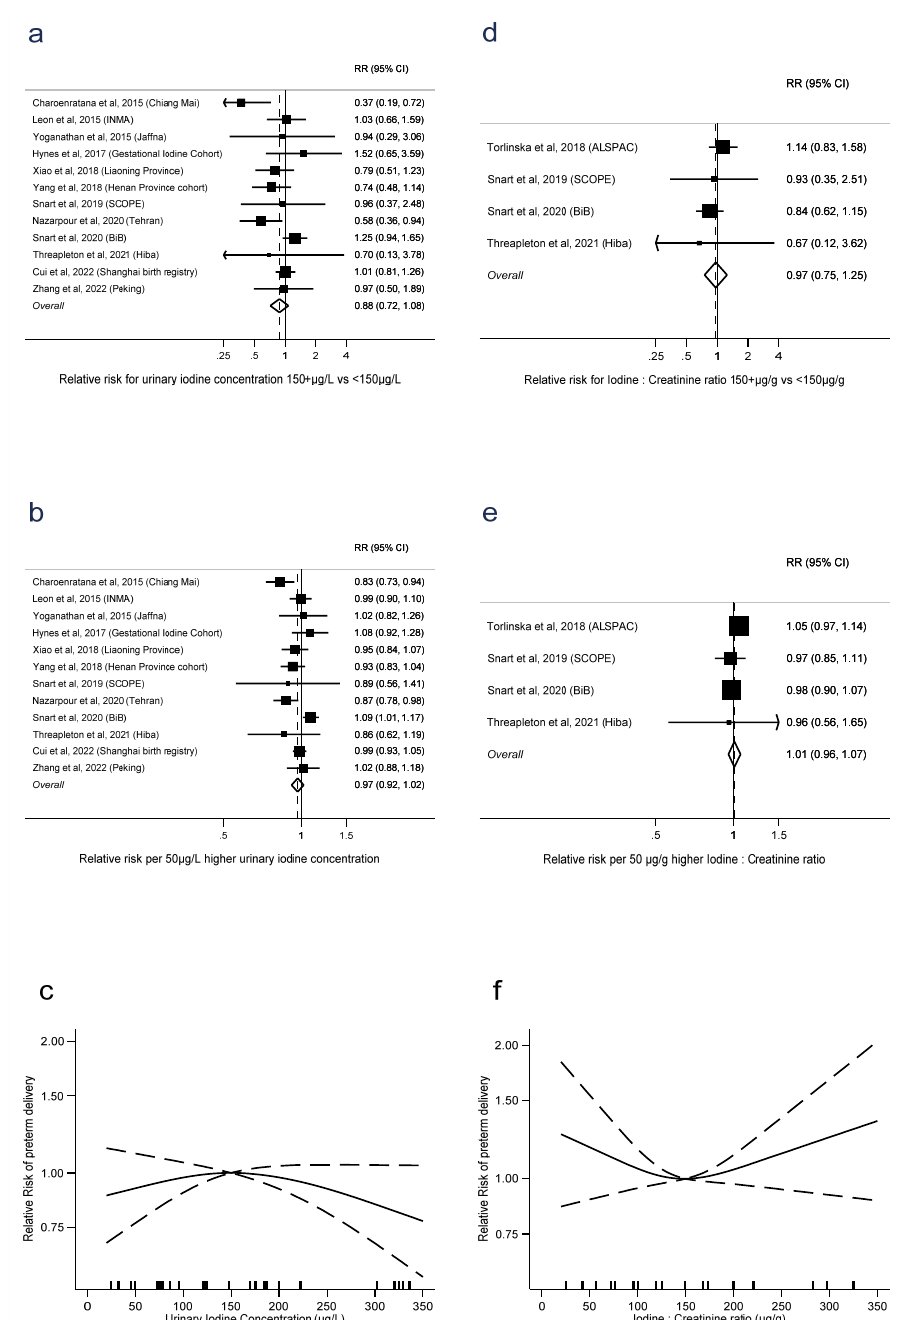
Figure 5. Urinary iodine concentration ( a – c ), iodine to creatinine ratio ( d – f ) and preterm delivery, di- chotomous ( a , d ), linear ( b , e ), and nonlinear ( c , f ) meta-analyses. CI: Confidence interval; RR: Relative risk